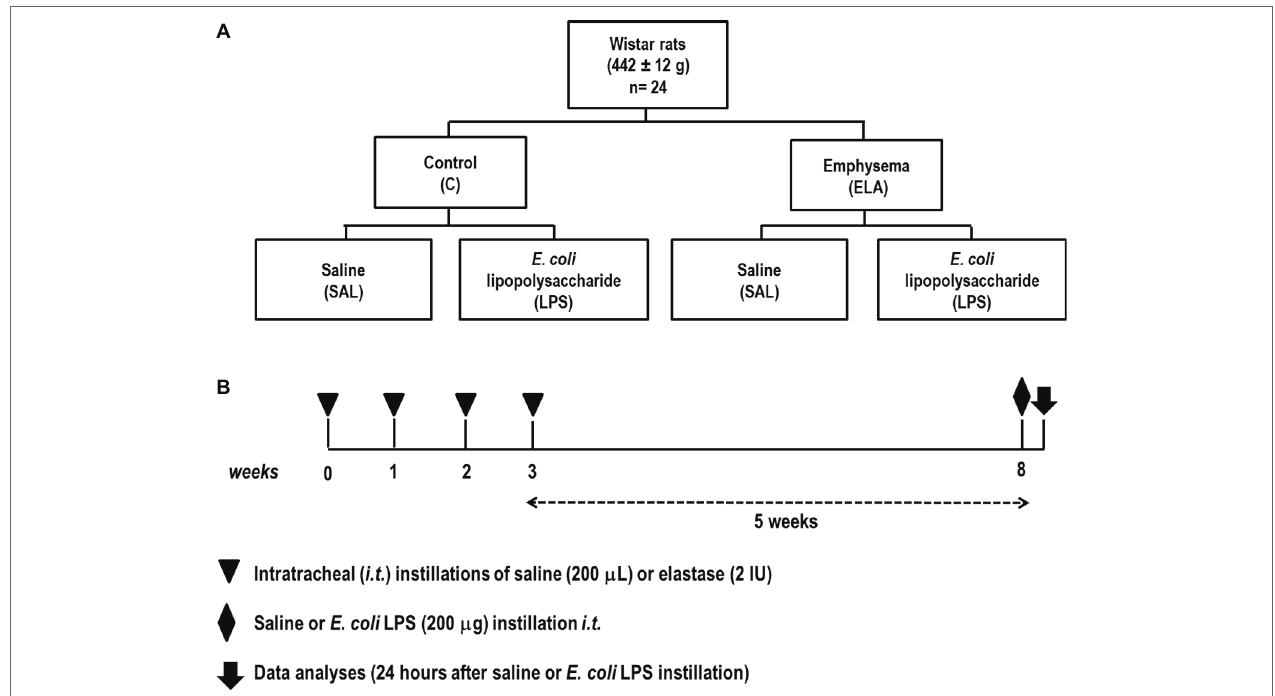
FIGURE 1 | (A) Schematic flow chart and (B) timeline of the study design. Animals were randomly assigned into two main groups: control (C) and emphysema (ELA). In the ELA group, animals received four intratracheal instillations of pancreatic porcine elastase (PPE) at 1-week intervals. The C group received saline alone using the same protocol. Five weeks after the last instillation, C and ELA animals received saline (SAL) or E. coli LPS (LPS)